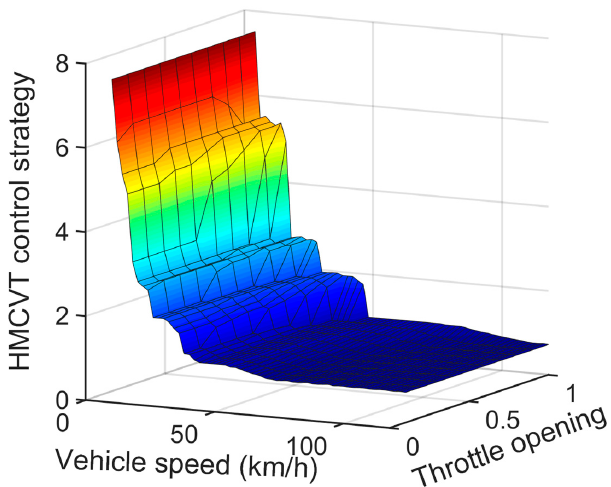
Figure 6. Optimal economic transmission ratio control strategy map of HMCVT.